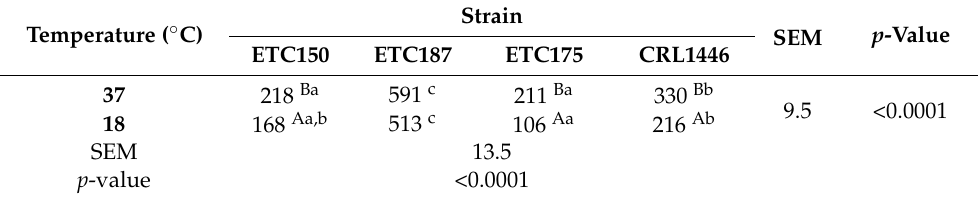
Table 2. Effect of temperature on Ferulic acid esterase (FAE) activity at pH 7.0.